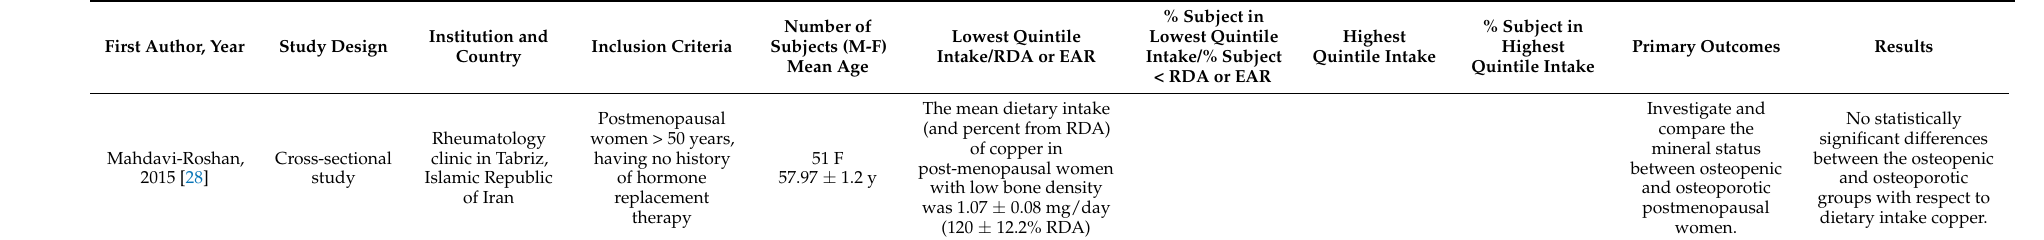
Table 2. Studies that considered copper intake.